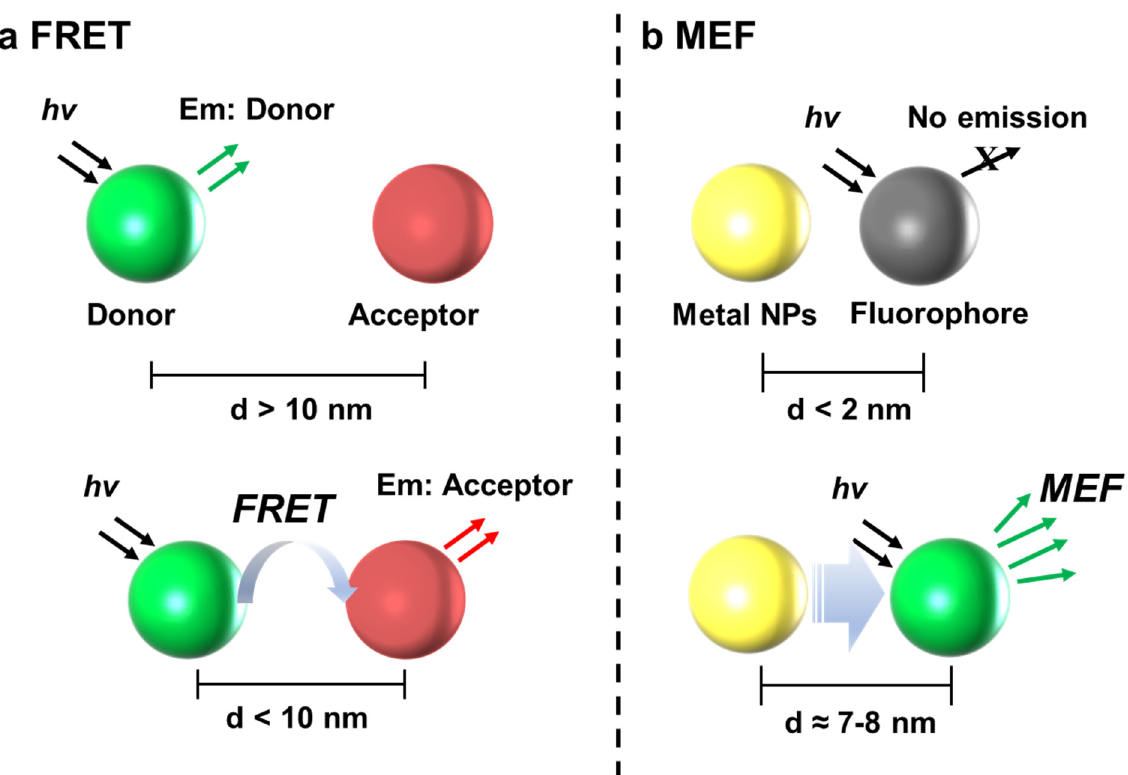
Figure 1. The simple mechanism of the ( a ) FRET and ( b ) MEF phenomena. FRET is induced when the distance between donor and acceptor is <10 nm. In the case of MEF, metal NPs can enhance the fluorescence intensity of fluorophore when the distance is around 7~8 nm. Table 1. Comparison of FRET-based nanobiosensors for nucleic acid detection.